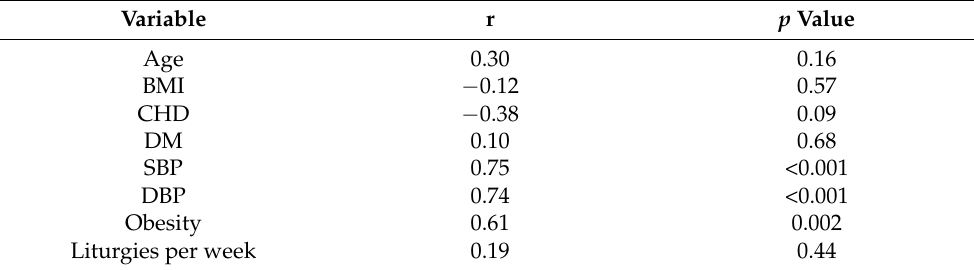
Table 2. Relationship between prevalence with demographic and clinical variables.